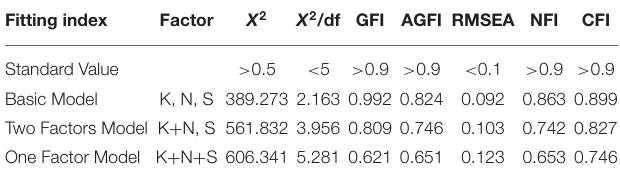
TABLE 4 | Factor analysis results.